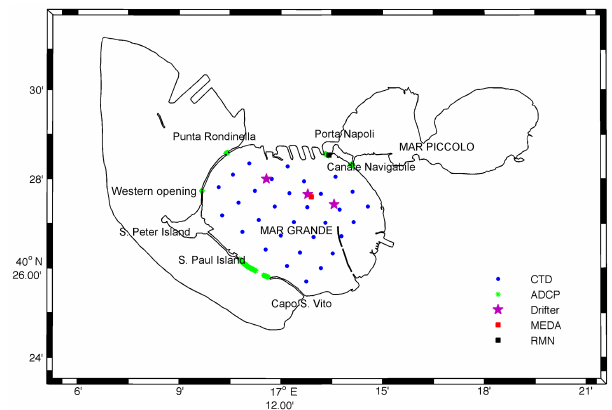
Figure 2. Map of the Mar Grande study area and points/locations of available measurement datasets from the MREA14 campaign (CTD, ADCP and drifters), the Italian Mareographic Network (RMN) and the Mar Grande station